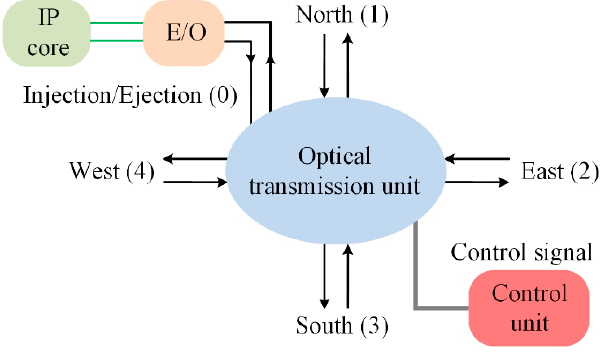
Figure 2. General 5×5 optical router model. Figure 2. General 5 × 5 optical router